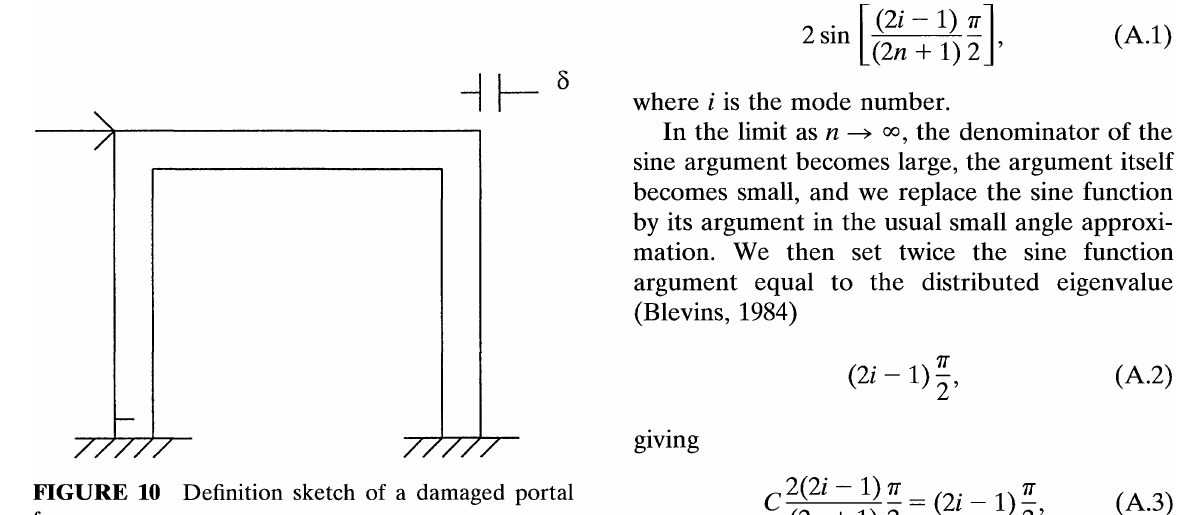
FIGURE 10 Definition sketch of a damaged portal